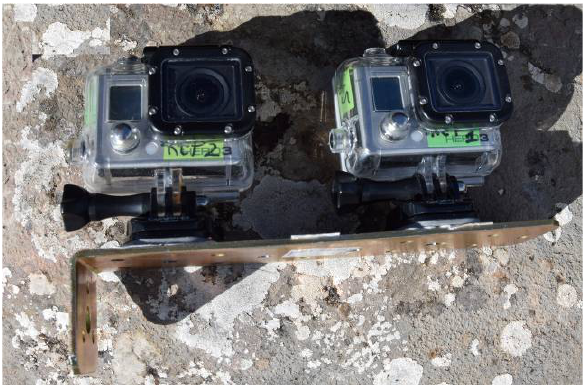
Figure 4. Scubalibre Hardware -